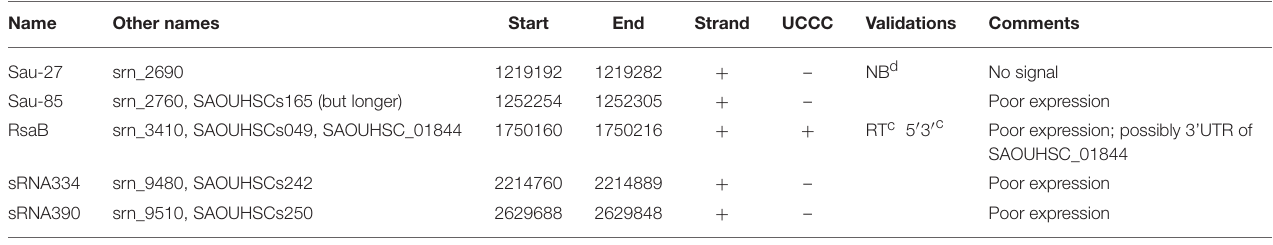
TABLE 2 | Bona fide sRNAs in HG003 with poor expression in the tested conditions of RNA-seq (this study) and tiling arrays (Mäder et al., 2016) datasets.